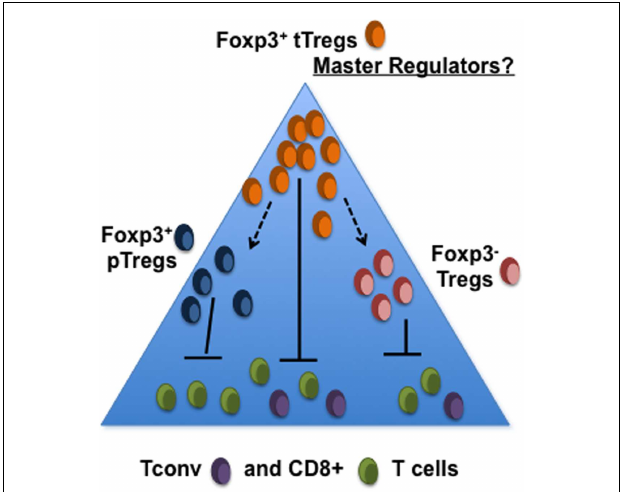
FIGURE 1 |Are intra-tumoral Foxp3 + t regs simply the tip of the iceberg? The tumor microenvironment may consist of several subsets ofT reg that serve to suppress the activities of tumor-specific CD4 + and CD8 + T cells. It is not yet known whether development of pT reg or suppressor activity within CD4 + Foxp3 − T population requires the presence of tT reg .